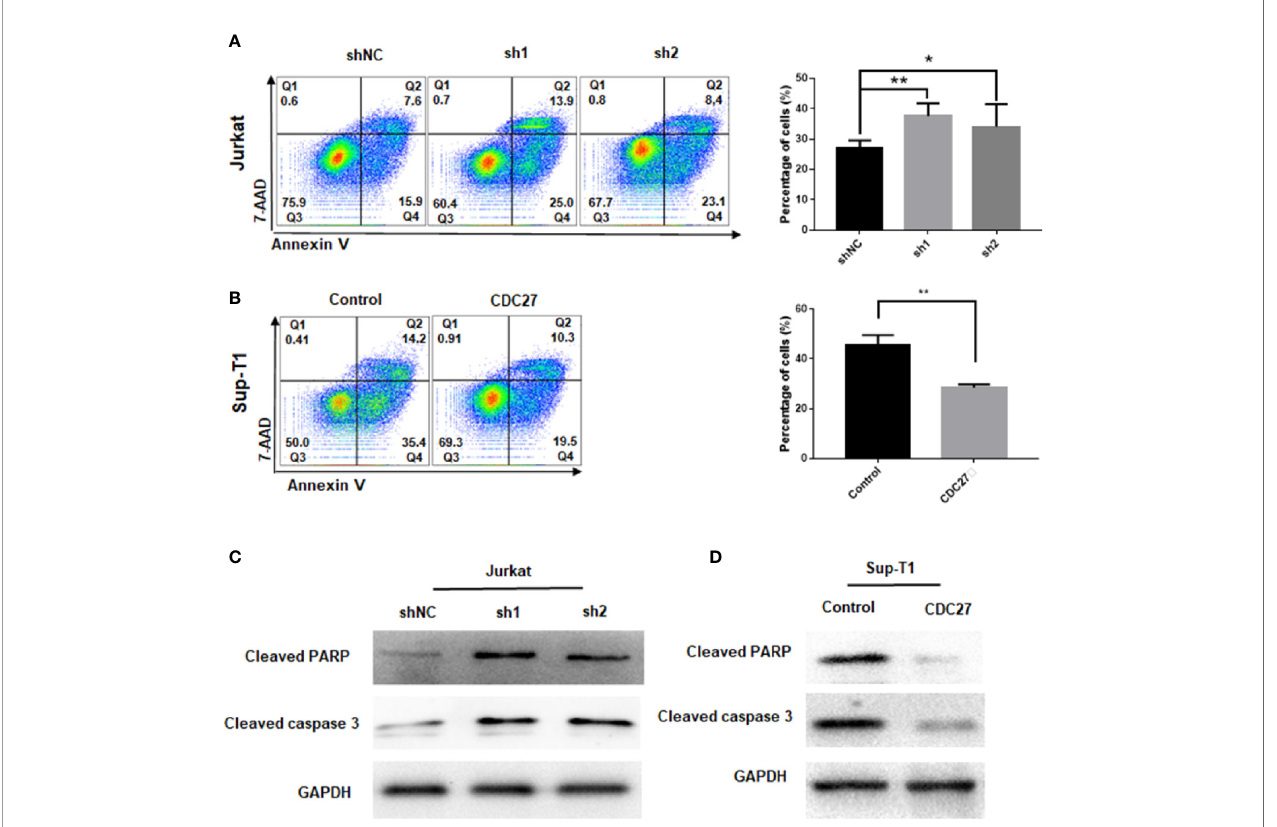
FIGURE 4 | CDC27 inhibits cell apoptosis in T-LBL cells. (A, B) Flow cytometry was used to examine the apoptosis as the sum of both Q2 and Q4 quadrants (early + late apoptosis) by Annexin V/7-AAD staining of both Jurkat and Sup-T1 cells. Apoptosis rates were expressed as the mean (Q2 + Q4) ± SD of values from experiments performed in triplicate by using Student ’ s t-test. * P < 0.05, ** P < 0.01. (C, D) Western blot was performed to detect the expression levels of apoptotic related proteins in both Jurkat and Sup-T1 cells,